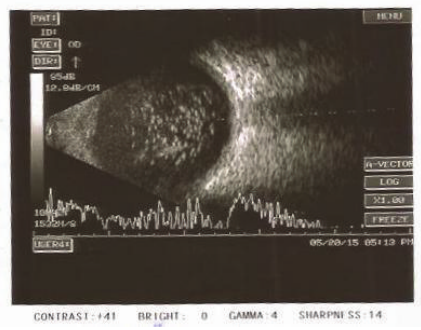
Figure 6: Left eye (Patient 2) B-scan ultrasonography shows resolution of choroidal